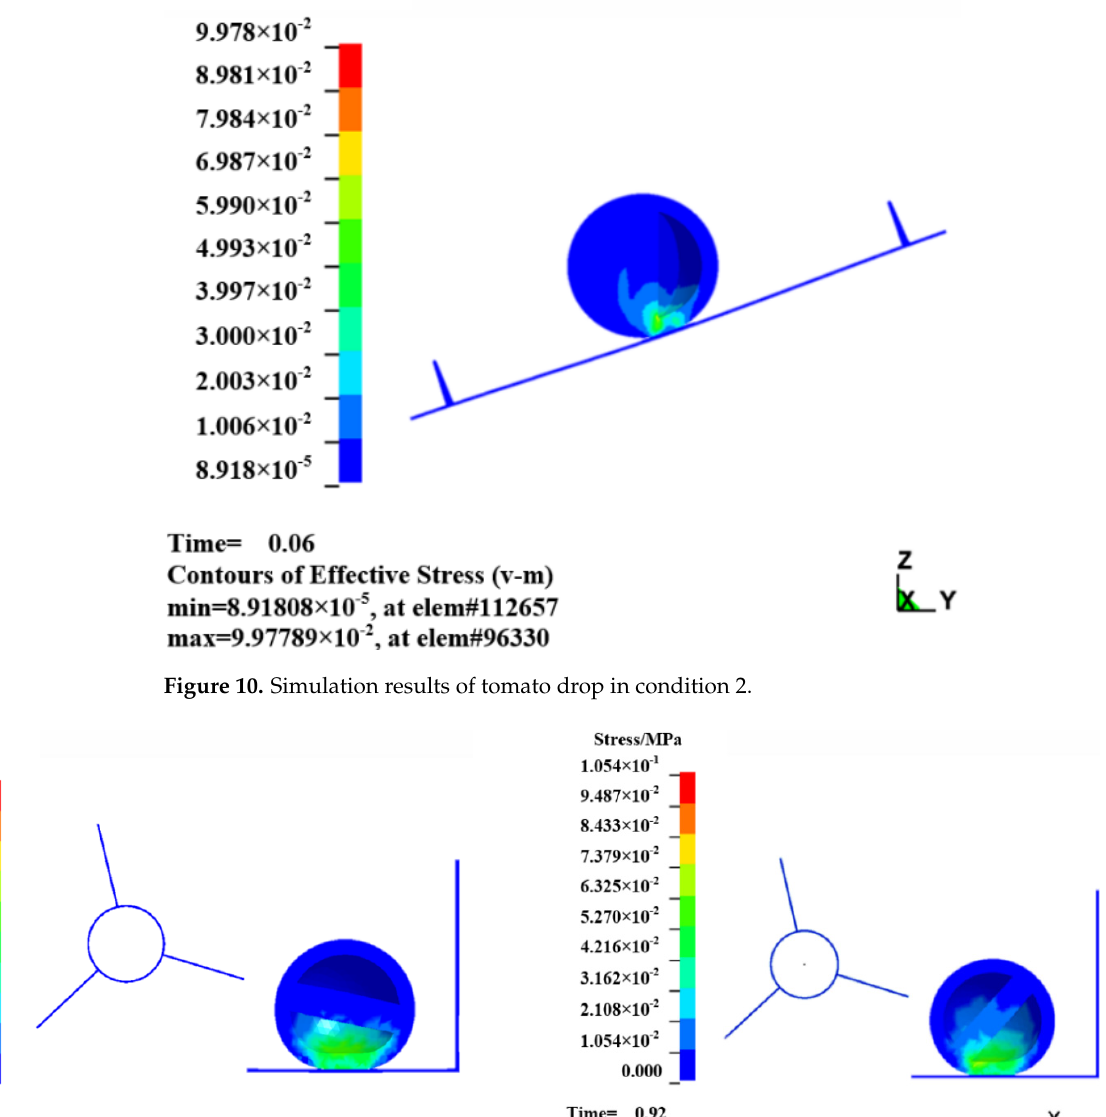
( b ) Figure 9. Simulation results of tomato drop in condition 1. ( a ) The falling displacement of the tomato ( b ) The maximum stress on the tomato. For working condition 2 and working condition 3, the simulation results were shown in Figures 10 and 11, and the peak contact stress of tomato was 0.098 MPa and 0.121 MPa, respectively. In condition 3, the peak stress of the tomato was too close to its yield stress,